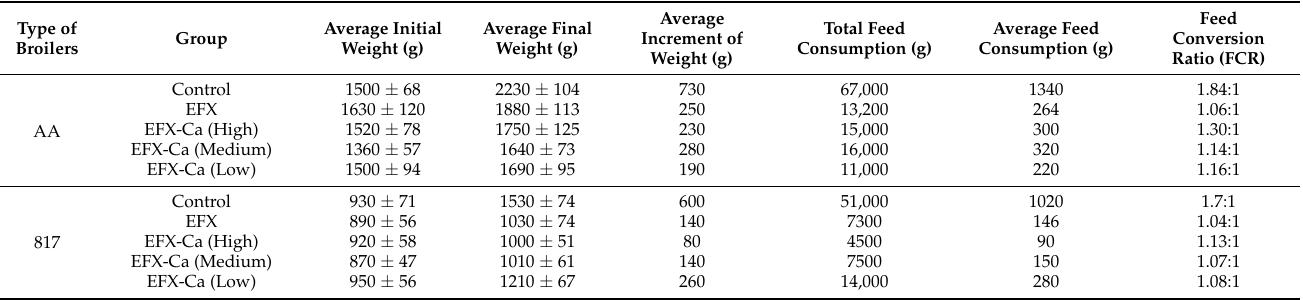
Table 8. The influence on the body weight, feed consumption and feed conversion ratios on two typical broilers after drug-mixed feeding of EFX and different dosage of EFX-Ca,